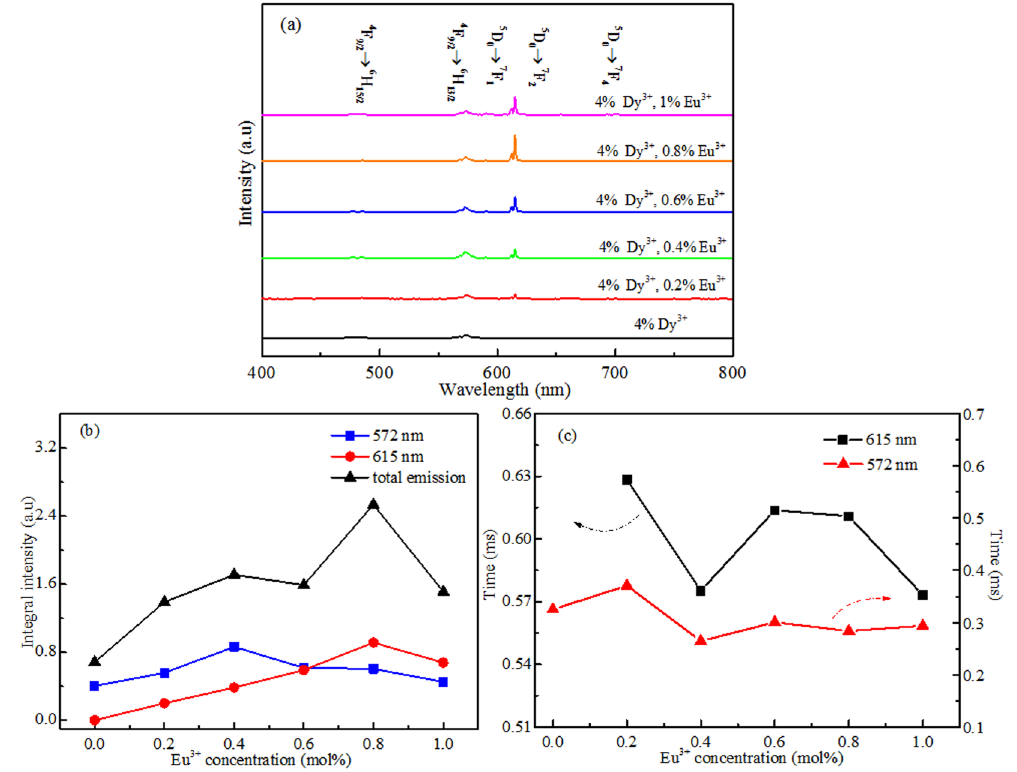
Figure 6. ( a ) PL emission spectra, ( b ) Integral intensity of Dy 3 + (572 nm), Eu 3 + (615 nm) and total emission, and ( c ) Calculated lifetimes of 4 F 9/2 and 5 D 0 energy levels of SrWO 4 : x Eu 3 + , 4 mol% Dy 3 + ( x = 0, 0.2 mol%, 0.4 mol%, 0.6 mol%, 0.8 mol%, 1 mol%) phosphors under 266 nm excitation at room